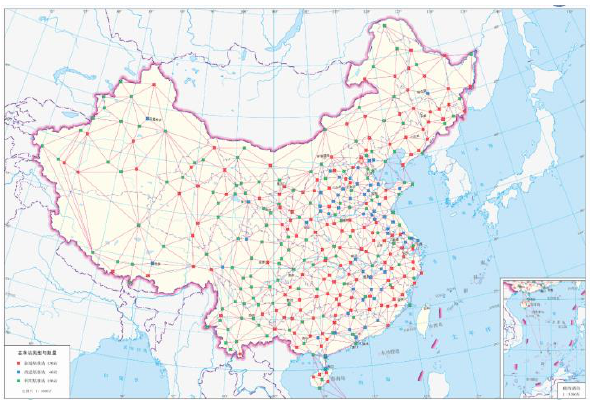
Figure 1. The map of national CORS